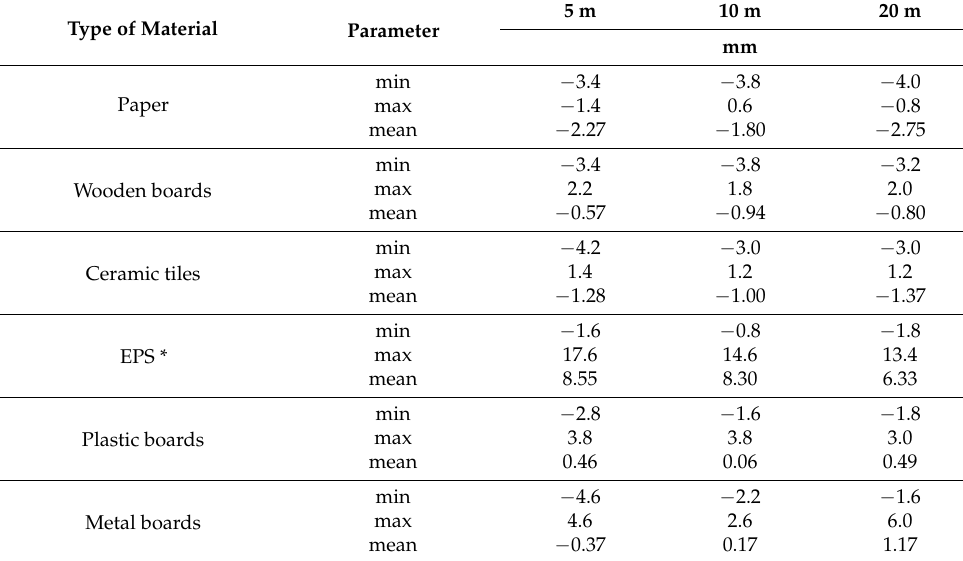
Table 2. Mean values of absolute RL EDM errors on distances: 5, 10 and 20